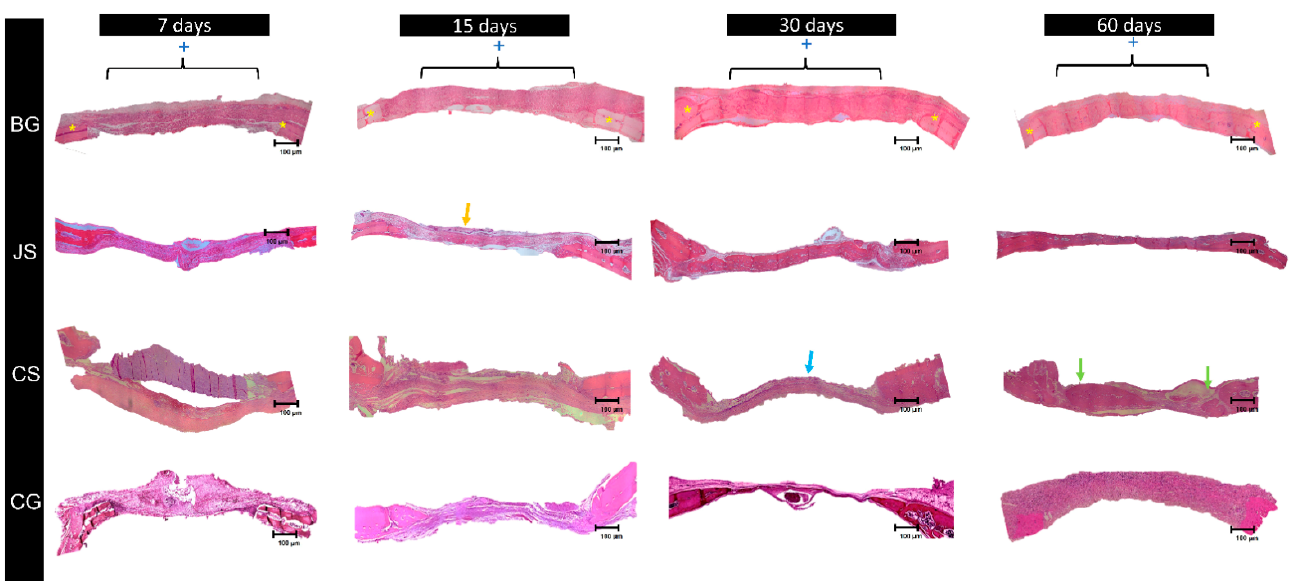
Figure 3. Panoramic reconstructions of the photomicrographs of the BG, JS, CS, and CG groups at all experimental times at 6.3 × magnification. The 8 mm defect is delimited by the [ ] and indicated by the + symbol, the yellow * indicates the location of the bony stumps.